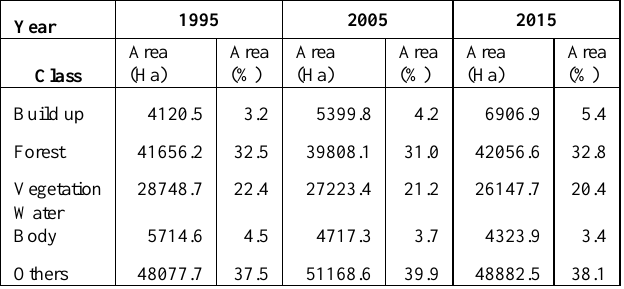
Table 3. Temporal Land use changes from 1995 to 2015